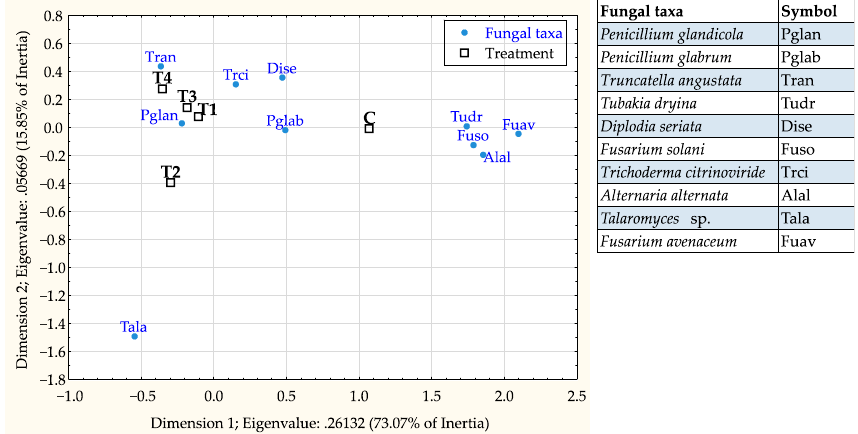
Figure 6. Correspondence analysis map showing association of the 10 most frequent fungal taxa with acorn thermotherapy treatment categories (C = control, T1 = at 41 °C for 2.5 h, T2 = at 41 °C for 5 h, T3 = at 45 °C for 2.5 h, and T4 = at 45 °C for 5 h).